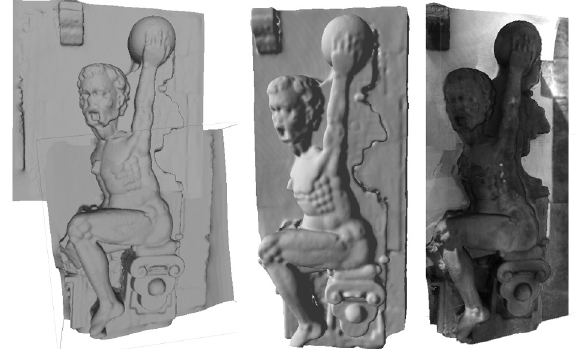
Figure 10: Alignment of two single scans. Left false colours, right textured after vertex colour